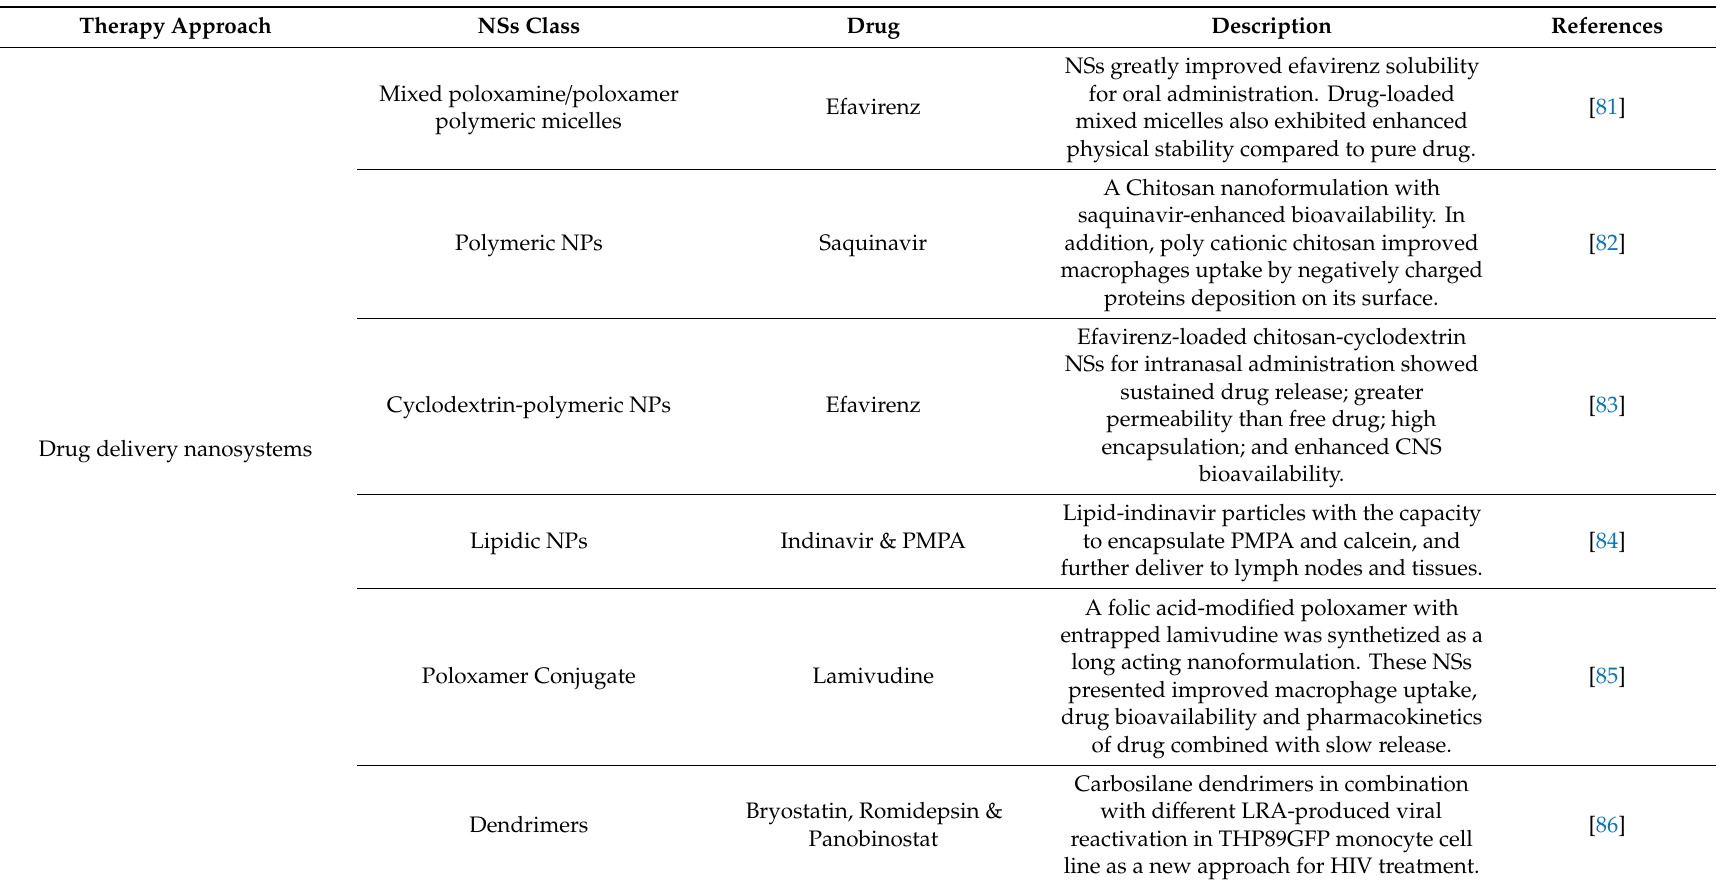
Table 3. Nanotechnology approaches for HIV / AIDS